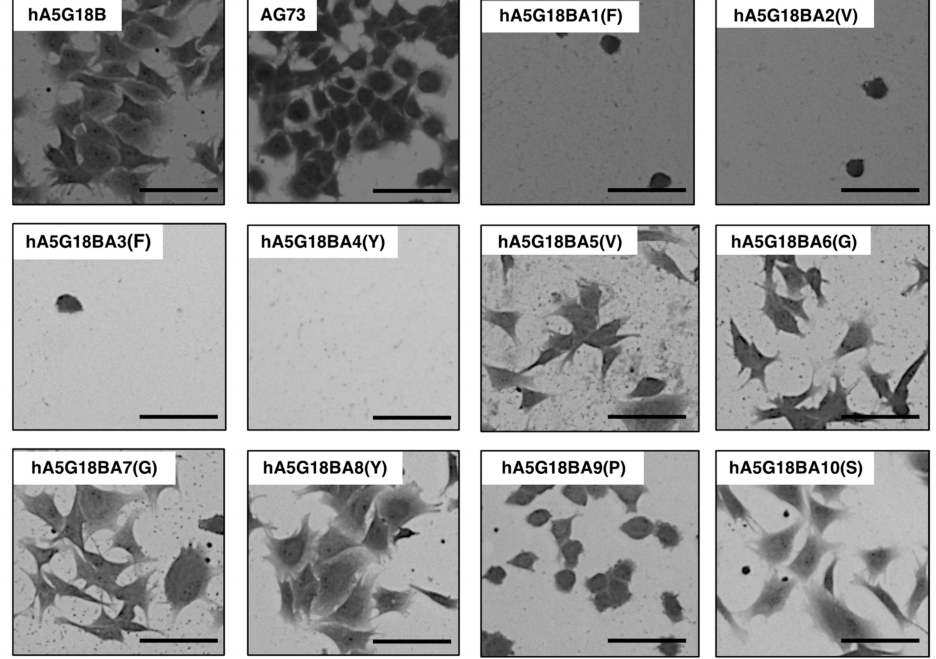
Figure 4. MorphologicalappearanceofHDFsonpeptide-coatedplates. Peptides(2nmol/wellofhA5G18B and hA5G18BA1-10, 0.4 nmol/well of AG73) were coated on plates and HDFs (2 × 10 4 cells/well)